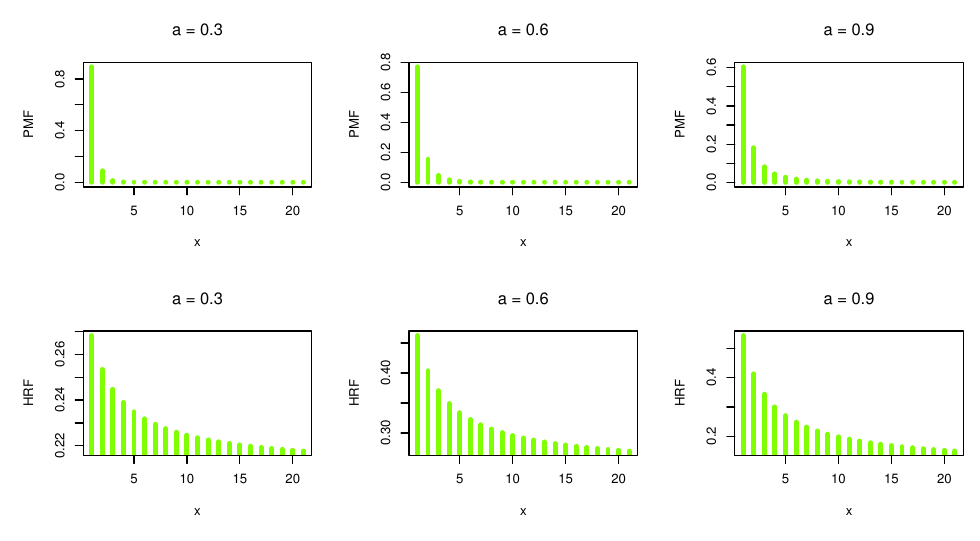
Figure 1. PMF and HRF